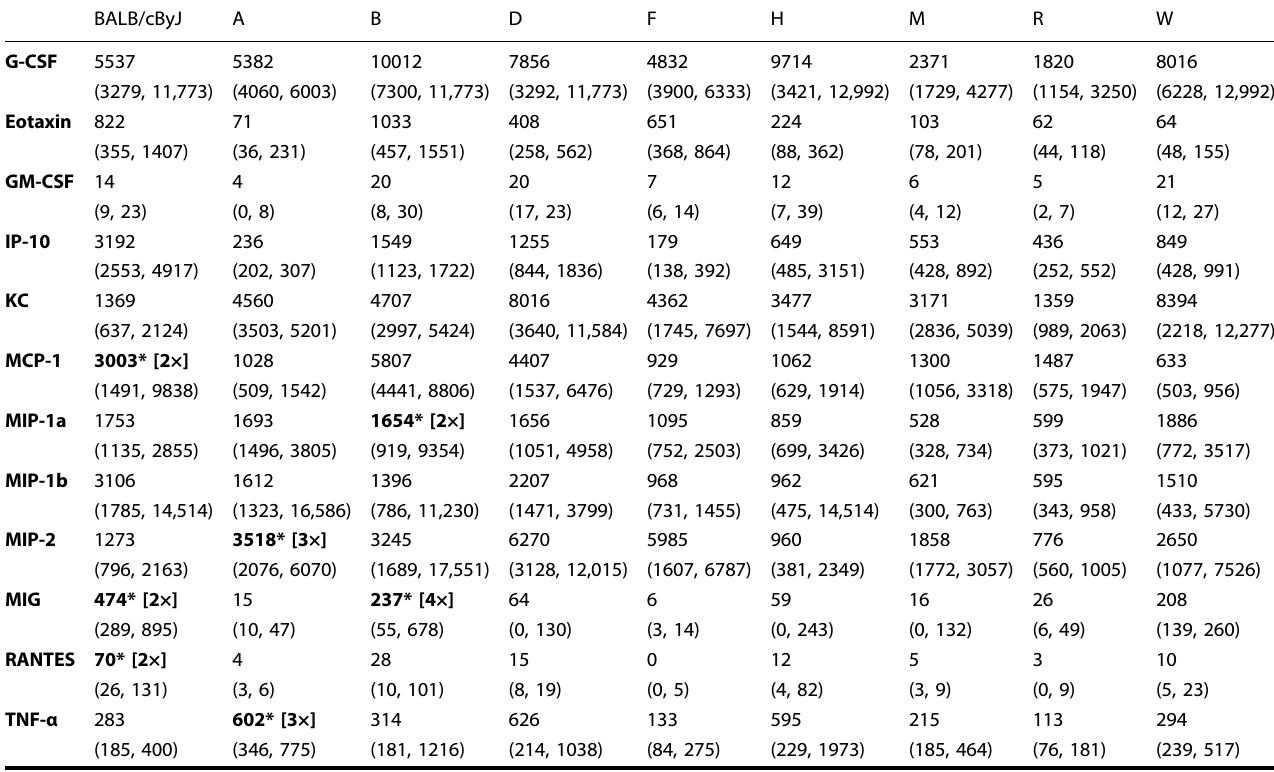
Table 2. Cytokine and chemokine pro fi les in fl uid recovered from diffusion chambers implanted in BALB/cByJ and 8 CC-RIX Lines.